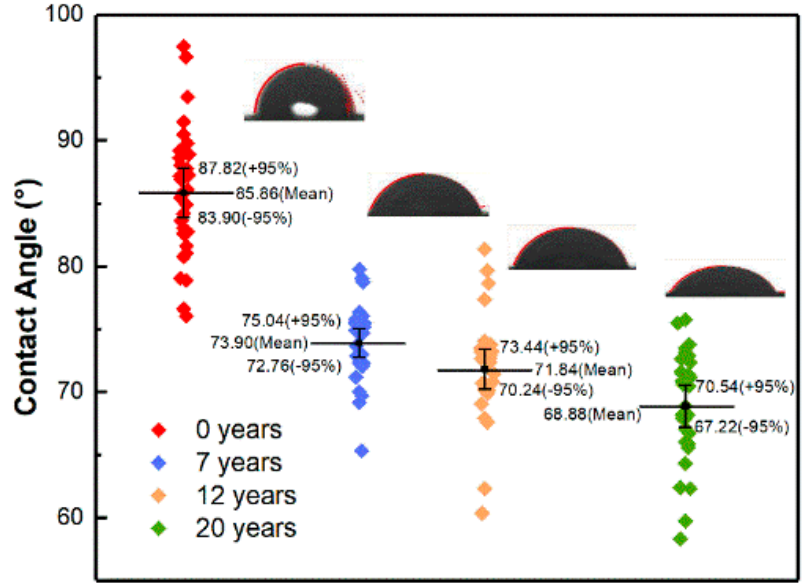
Figure 6. Mean values and 95% confidence intervals of contact angles of epoxy primer-coated specimens exposed for different numbers of years.